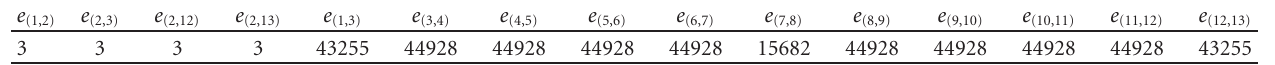
Table 5: Number of writes to the connectors ( w